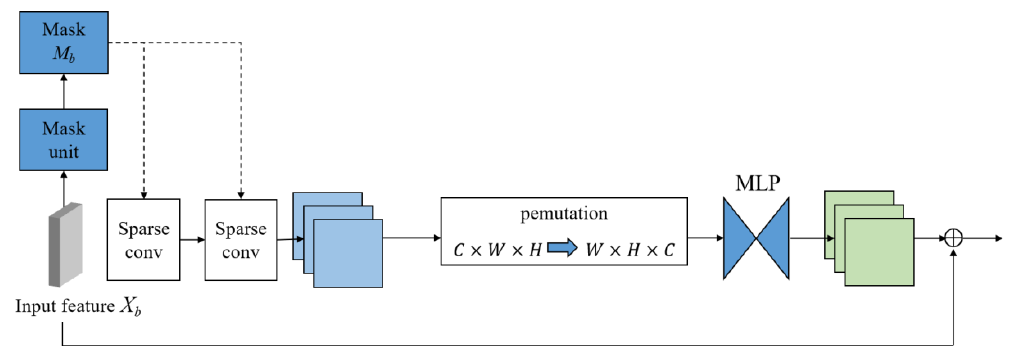
Figure 2. The structure of Sparse Mask Attention Learning.